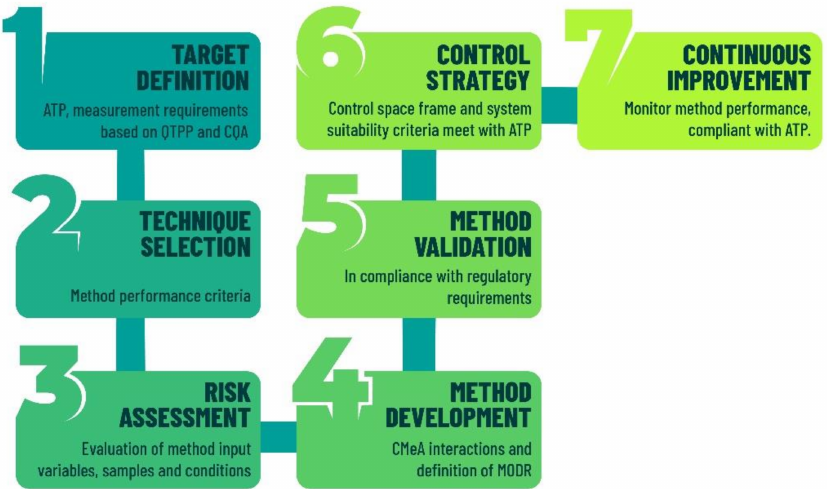
Figure 1. Implementation stages of AQbD, modified from Ramalingam and Jahnavi [30].